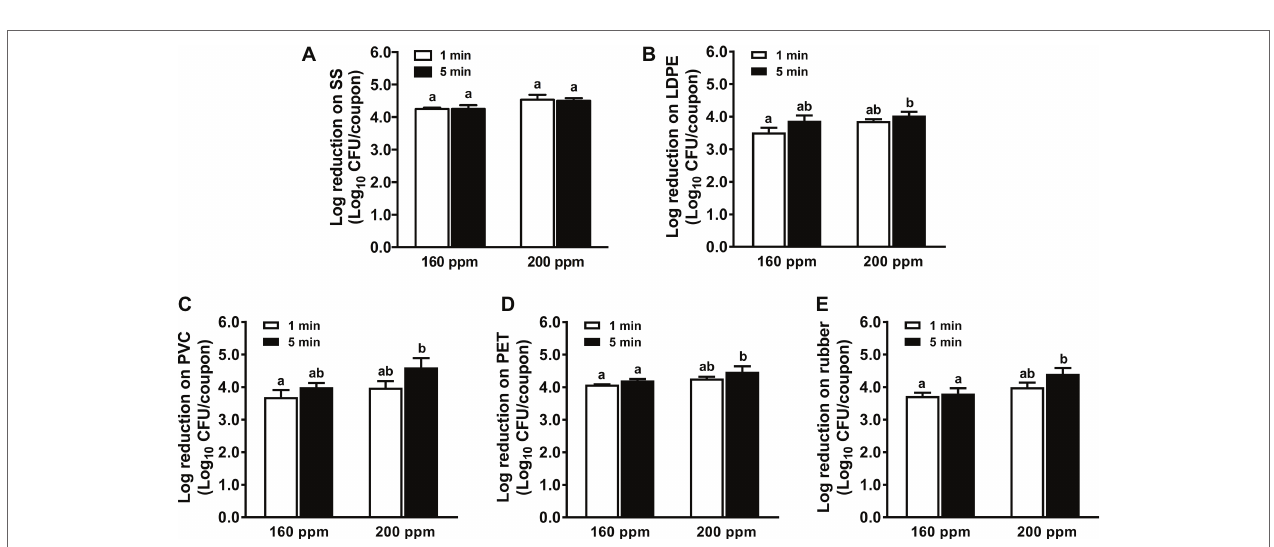
FIGURE 4 | Antimicrobial efficacy of peroxyacetic acid (PAA) against L. monocytogenes biofilms on food-contact surfaces. (A) Stainless steel (SS); (B) low-density polyethylene (LDPE); (C) polyvinyl chloride (PVC); (D) polyester (PET); (E) rubber. The 7-day-old biofilms on different surface coupons (15 mm × 7.5 mm) were treated with 160 or 200 ppm PAA for 1 or 5 min at 22 ° C. The surviving bacteria were shown as means ± SEMs, n = 3. a,b Bars topped with the different letters are significantly different at p ≤